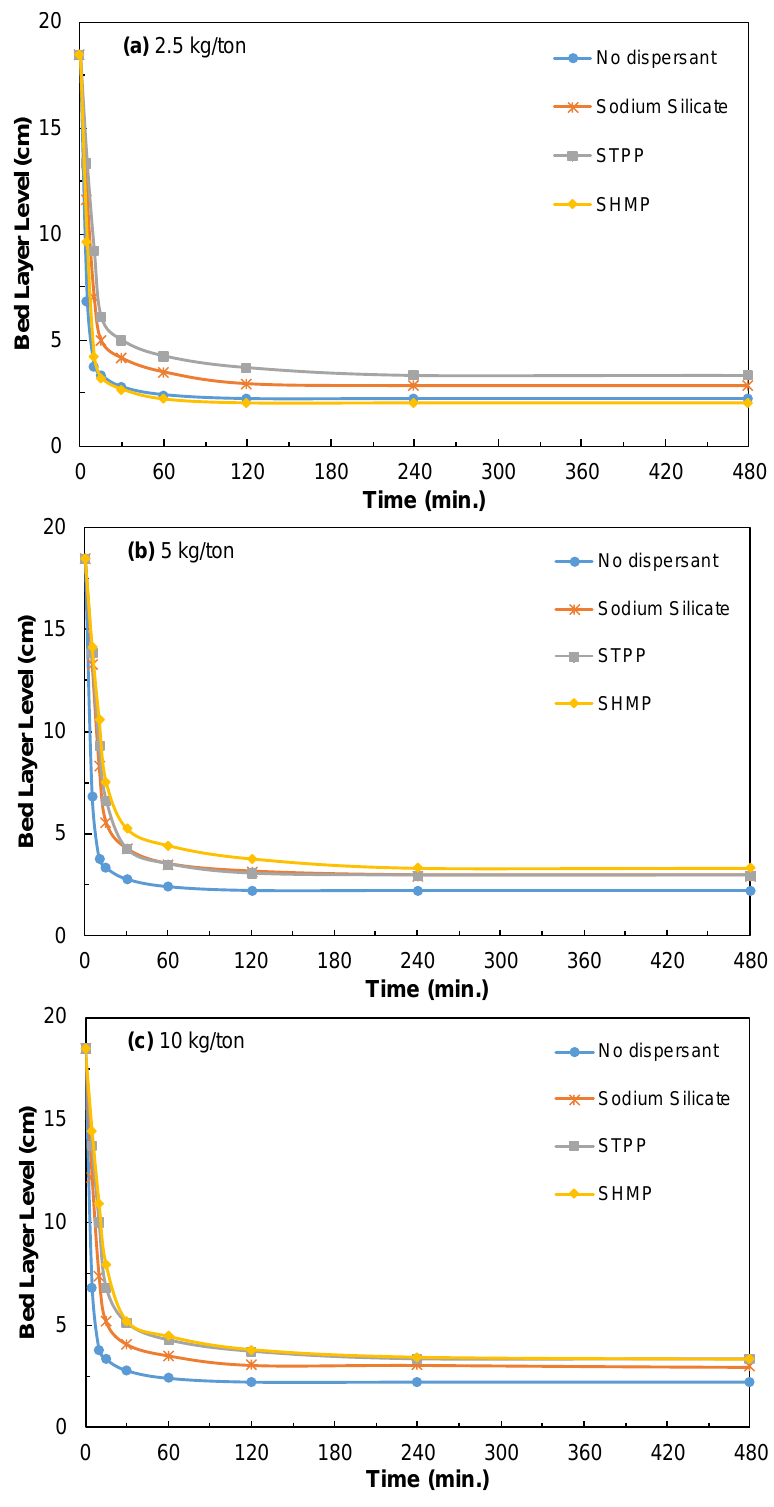
Figure 9. Halloysite sedimentation behavior in the presence of dispersants at concentrations of ( a ) 2.5 kg/ton, ( b ) 5 kg/ton, and ( c ) 10 kg/ton at natural pH and room